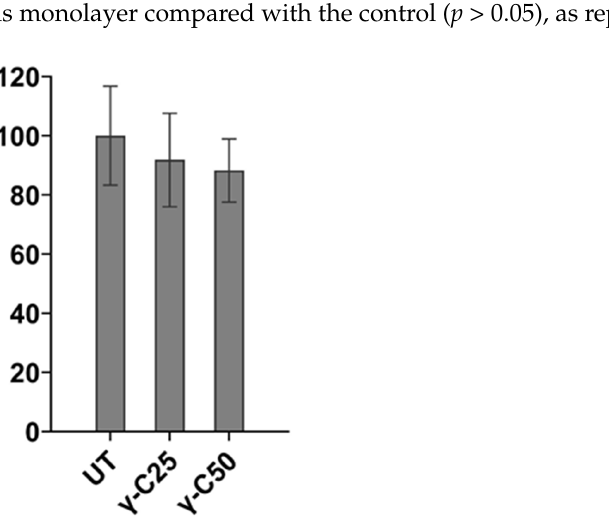
Figure 3. Transepithelial resistance (TEER) measured on IPEC-J2 cell line incubated for 24 h with 0.25 mg/mL ( v / v , γ -C/culture medium, γ -C25) and 0.50 mg/mL ( v / v , γ -C/culture medium, γ -C50 group) compared with the untreated group (UT). Data are expressed as mean ± standard deviation ( p > 0.05).